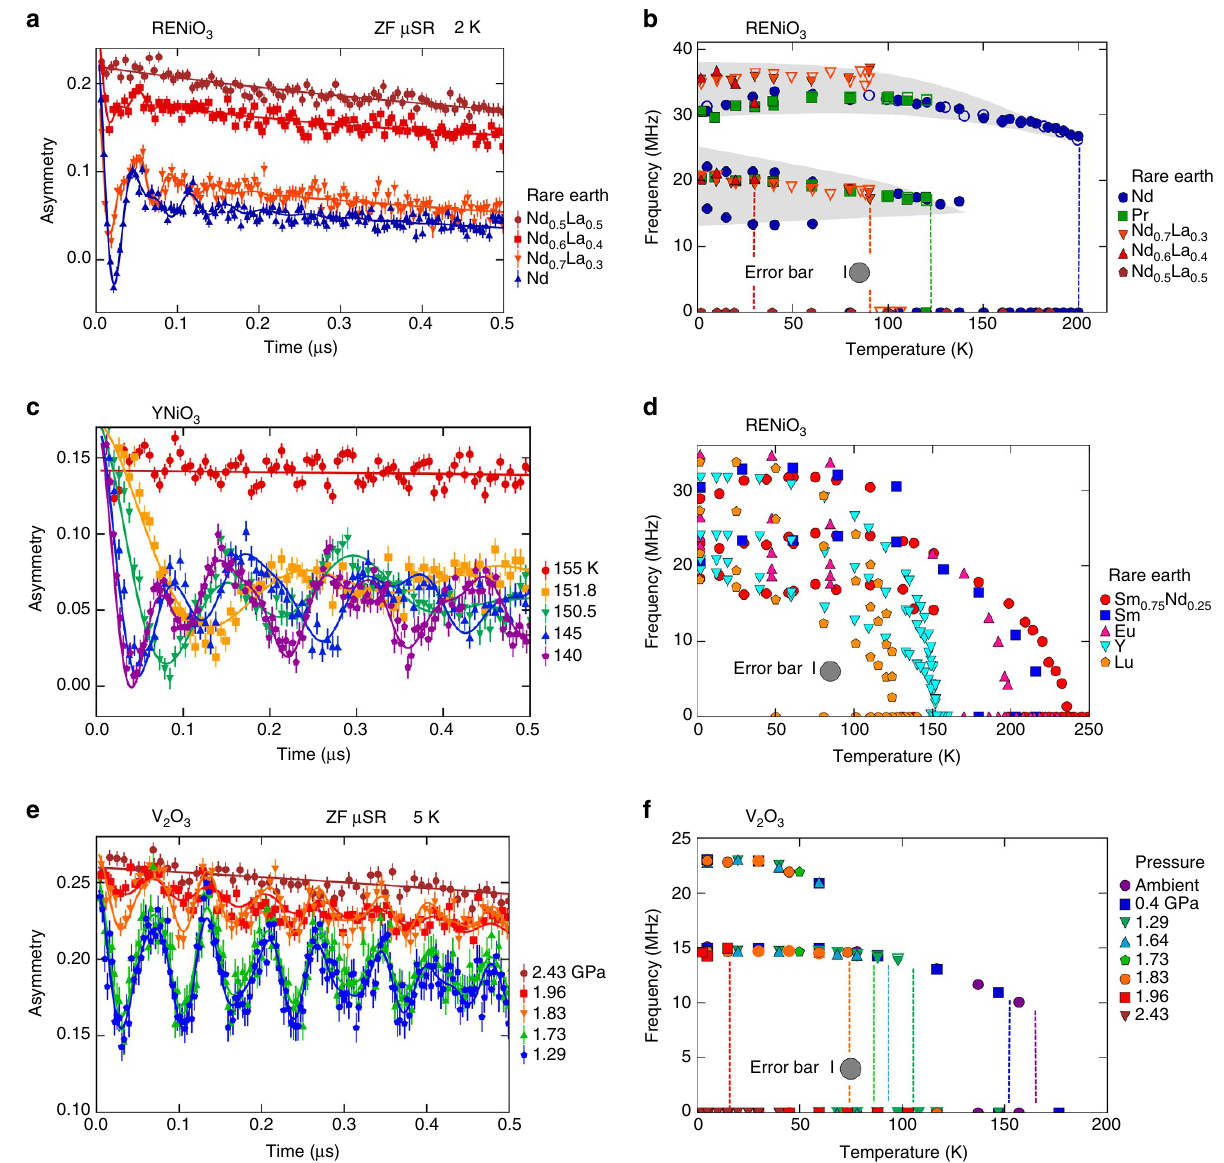
Figure 2 | Zero-field (ZF) muon spin relaxation ( l SR) experiments on RENiO 3 and V 2 O 3 . ( a ) ZF time spectra taken at 2K for four compounds of RENiO 3 near the quantum phase transition. The coloured dots represent the data, the solid curves the fits. The three magnetically ordered compounds show nearly identical oscillation frequencies (hence identical moment sizes) but very different oscillation amplitudes (hence different ordered volume fractions). ( b ) Temperature dependence of the oscillation frequencies for RENiO 3 compounds with first-order thermal phase transitions. Filled (open) circles represent data taken in a cooling (warming) sequence. All magnetically ordered compounds have two or three frequencies lying along two common bands (shaded grey regions), indicating that the ordered moment size does not change along the horizontal axis of the phase diagram. The large grey circle with the neighbouring vertical bar indicates the average estimated standard deviation (ESD) of the refined frequency produced from the least-squares minimization compared to the symbol size. The coloured dashed lines are guides to the eye showing the approximate transition temperature for each composition. ( c ) ZF spectra for YNiO 3 taken at various temperatures through the thermal phase transition. ( d ) Temperature dependence of the oscillation frequencies for RENiO 3 compounds with second-order-like thermal phase transitions, revealing the continuous development of the ordered moment size. ( e , f ) Plots for pressure-tuned V 2 O 3 corresponding to ( a , b